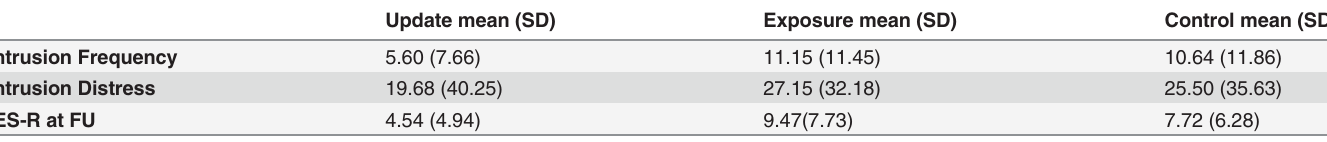
Table 7. Intrusion frequency, Intrusion Distress and IES-R for each